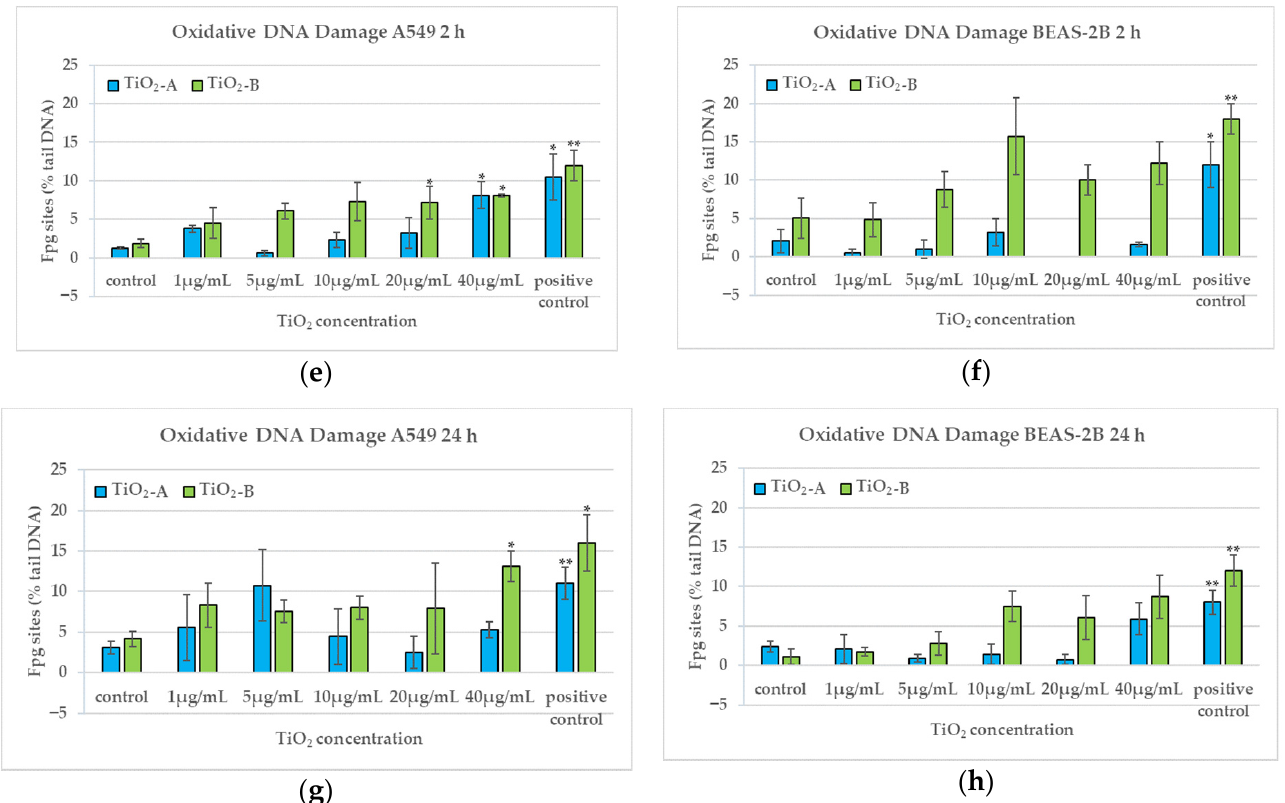
Figure 5. Direct and oxidative DNA damage in A549 and BEAS-2B cells after 2 h ( a , b , e , f ) and 24 h ( c , d , g , h ) exposure to TiO 2 NPs evaluated by the Fpg-comet test. * p < 0.05, ** p < 0.01. Data relative to TiO 2 -A are previously published in [10] (Reproduced with permission from [10]. Copyright John Wiley & Sons, Ltd., 2014).